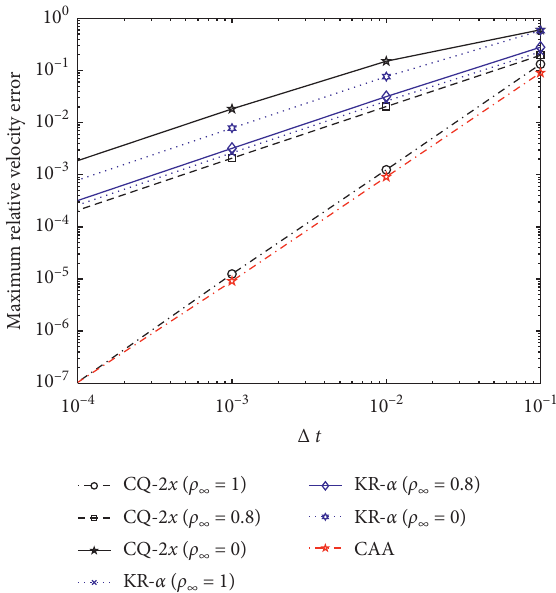
Figure 9: Convergence rate of CQ-2 x assessed in terms of the maximum relative velocity error.